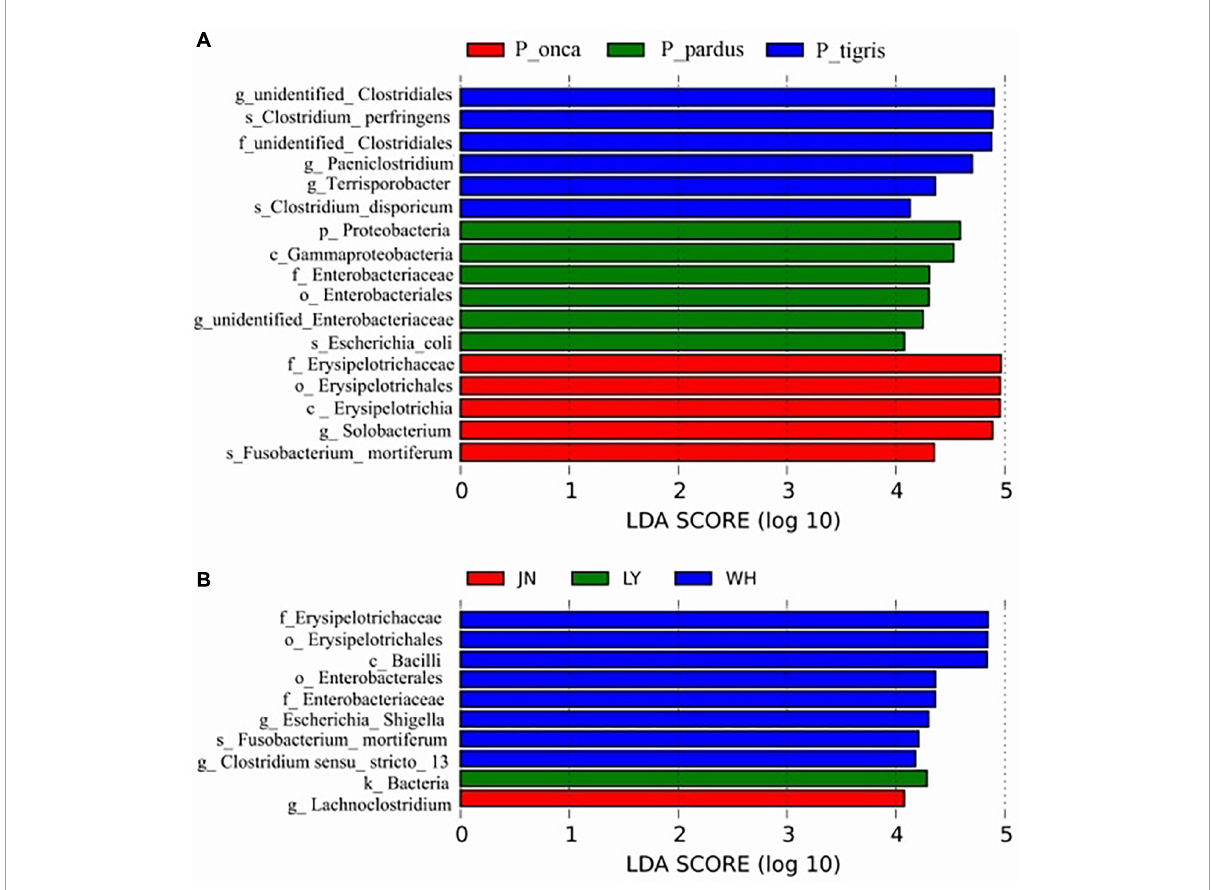
FIGURE3 LDA value distribution histogram shows the representative biomarkers in different species groups (A) and different sampling location groups (B) .